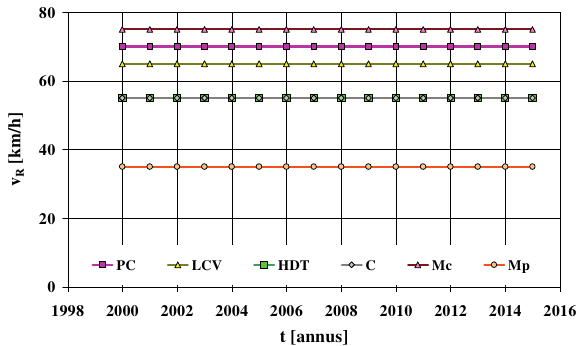
Fig. 9. National annual emission of carbon monoxide per cumulated vehicle category